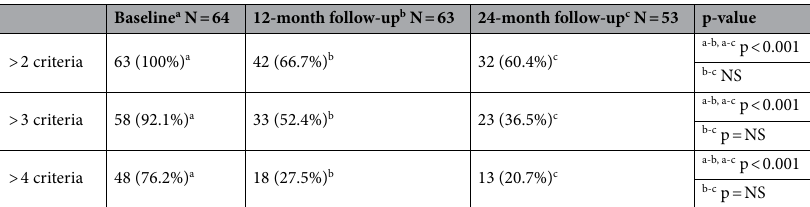
Table 3. Number of adenomyosis diagnostic sonographic criteria at baseline and at 12 and 24 months of follow-up. Results expressed as number and percentage or mean ± standard deviation. NS not